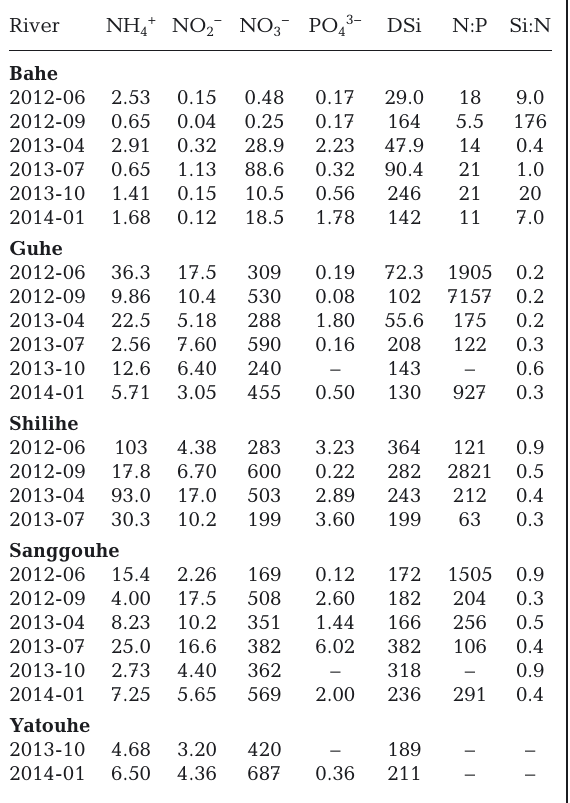
Table 2. Nutrient concentrations (µM) and molar ratios in surface water in rivers adjacent to Sanggou Bay, China, in different seasons during the study. DSi: dissolved silicate. Dates are given as